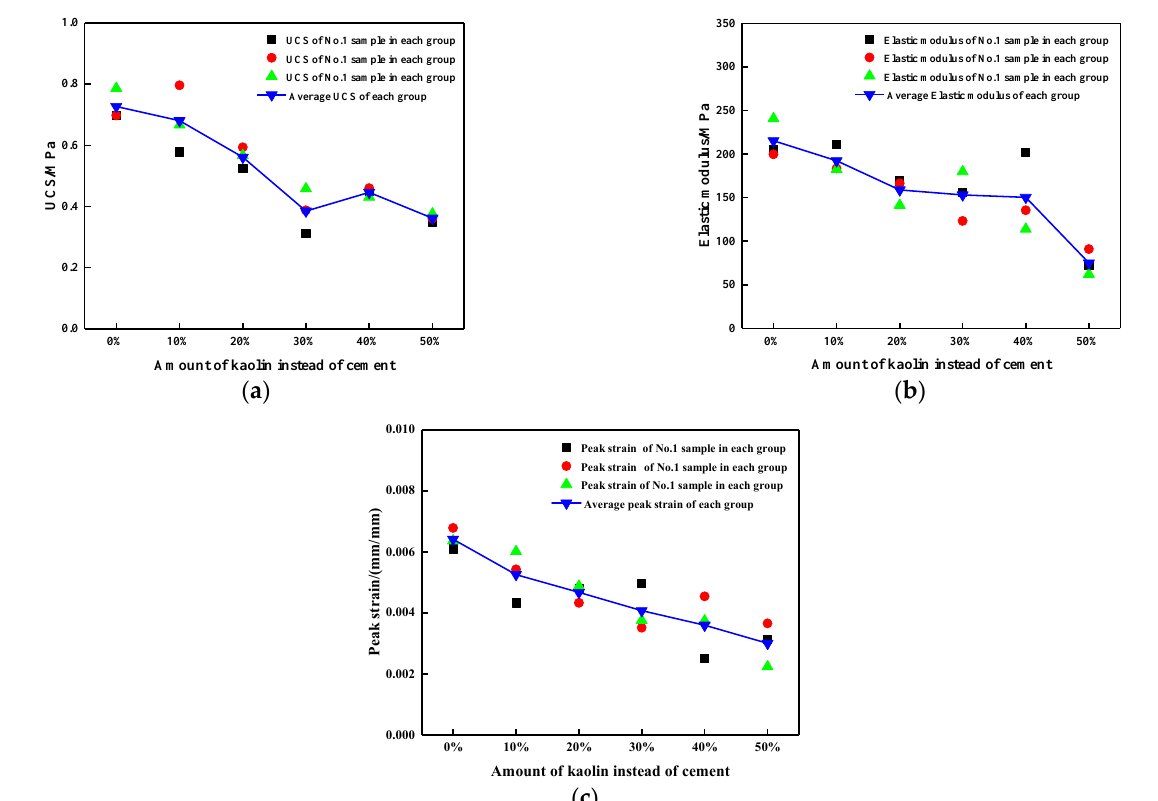
Figure 6. Comparisons of ( a ) UCS, ( b ) elastic modulus, and ( c ) peak strain of CGFB samples under different amounts of kaolin.